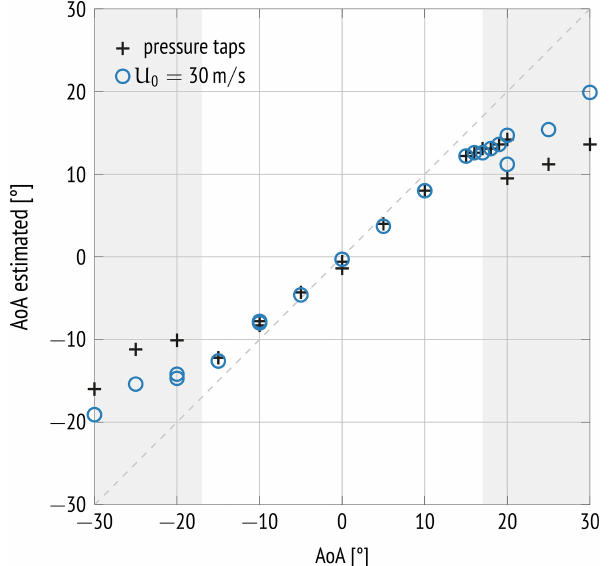
Figure 12. Estimation of the angle of attack using our method and a look-up table. Comparisons with estimation of the angle of attack from pressure taps are shown with the